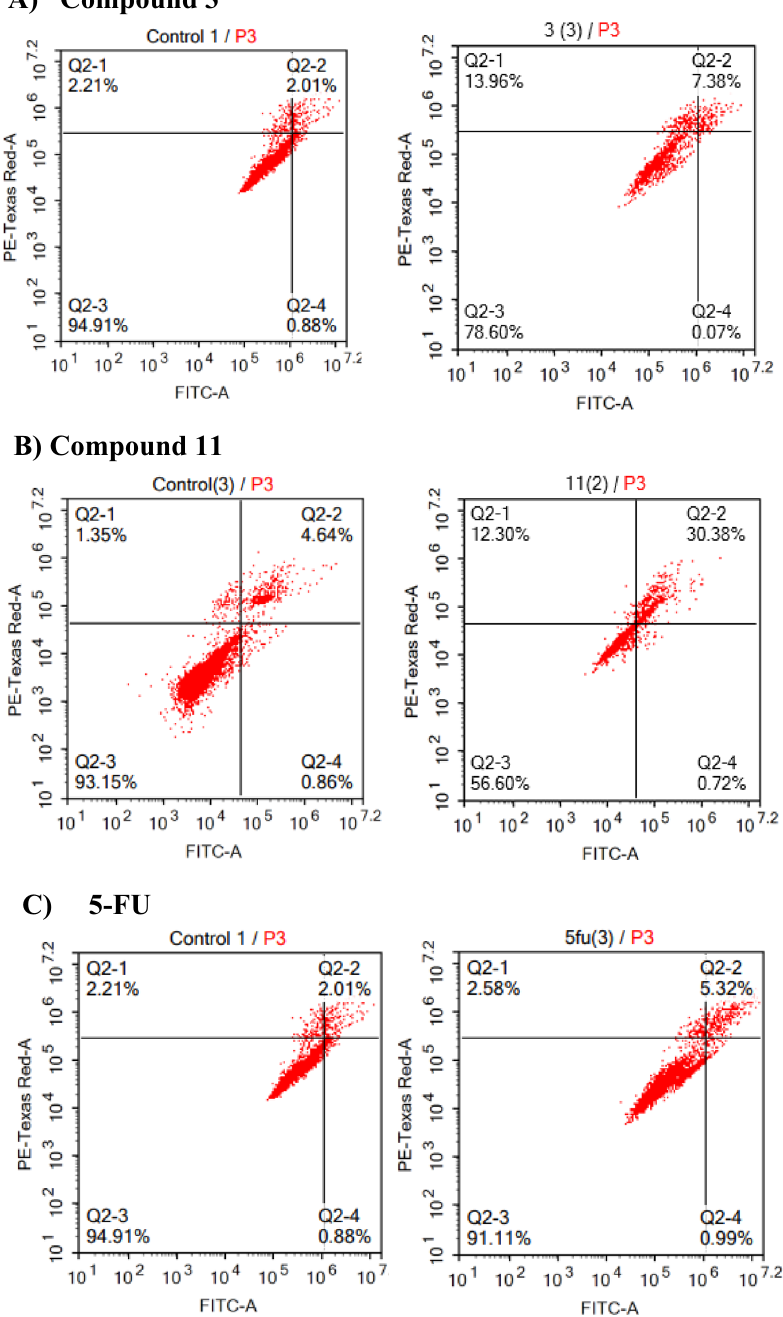
Figure 6. Apoptosis assessment for compounds 3 , 11 and 5-FU on HCT-116 cells; ( A ), ( B ), and ( C )